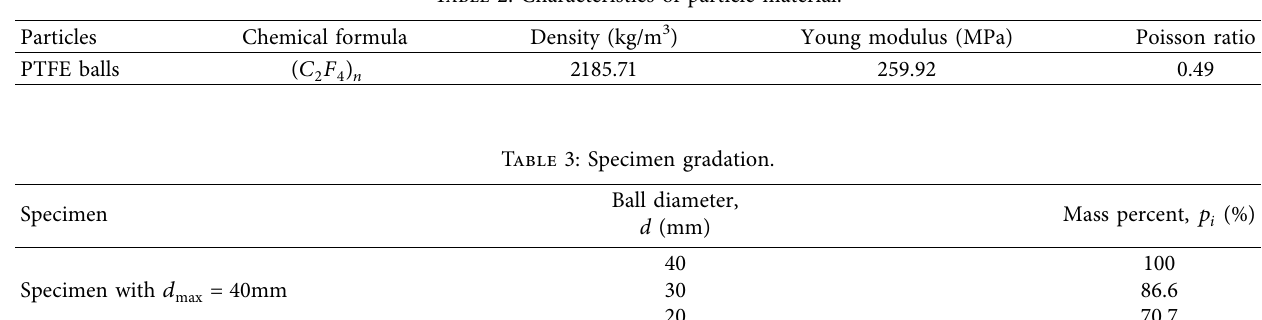
Figure 1: Balls used in tests (PTFE: polytetrafuoroethylene; d : ball diameter). Table 2: Characteristics of particle material.